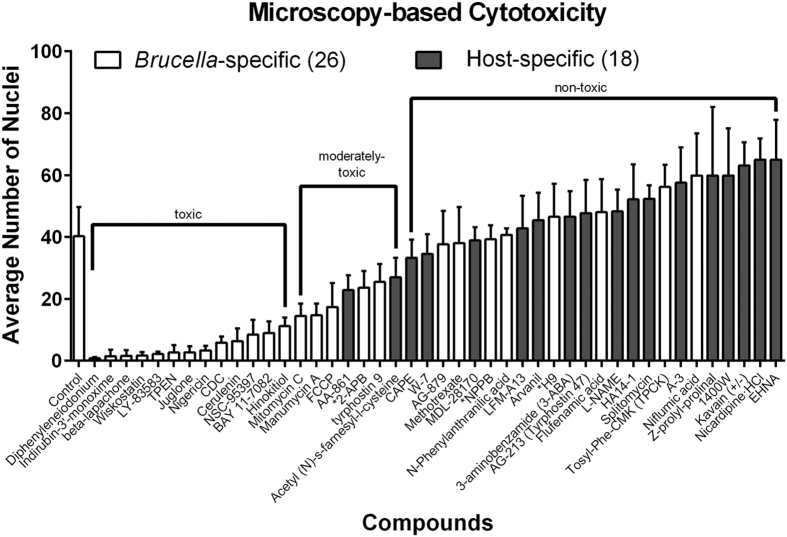
Microscopy-based assessment of hit compound cytotoxicity in Brucella-infected THP-1 cells.Cytotoxicity of the 26 Brucella-specific (white bars) and 18 host-specific compounds (shaded bars) was assessed by quantifying the average number of nuclei in a viewing area per each treatment. The results are expressed as an average number of nuclei calculated from 6–24 images per treatment in a single experiment. Error bars represent standard deviation. Toxic compounds were also identified based on a qualitative image analysis. Compounds that had a significantly lower average number of nuclei than control (p < 0.05) were deemed toxic. While compounds that are labeled as moderately-toxic had a lower average number of nuclei, the image analysis revealed adherent cells that had normal morphology (Supplementary Fig. S1). Compounds that had no apparent affect on morphology and had a high average number of nuclei were deemed non-toxic. *Three overlapping host- and Brucella-specific compounds.